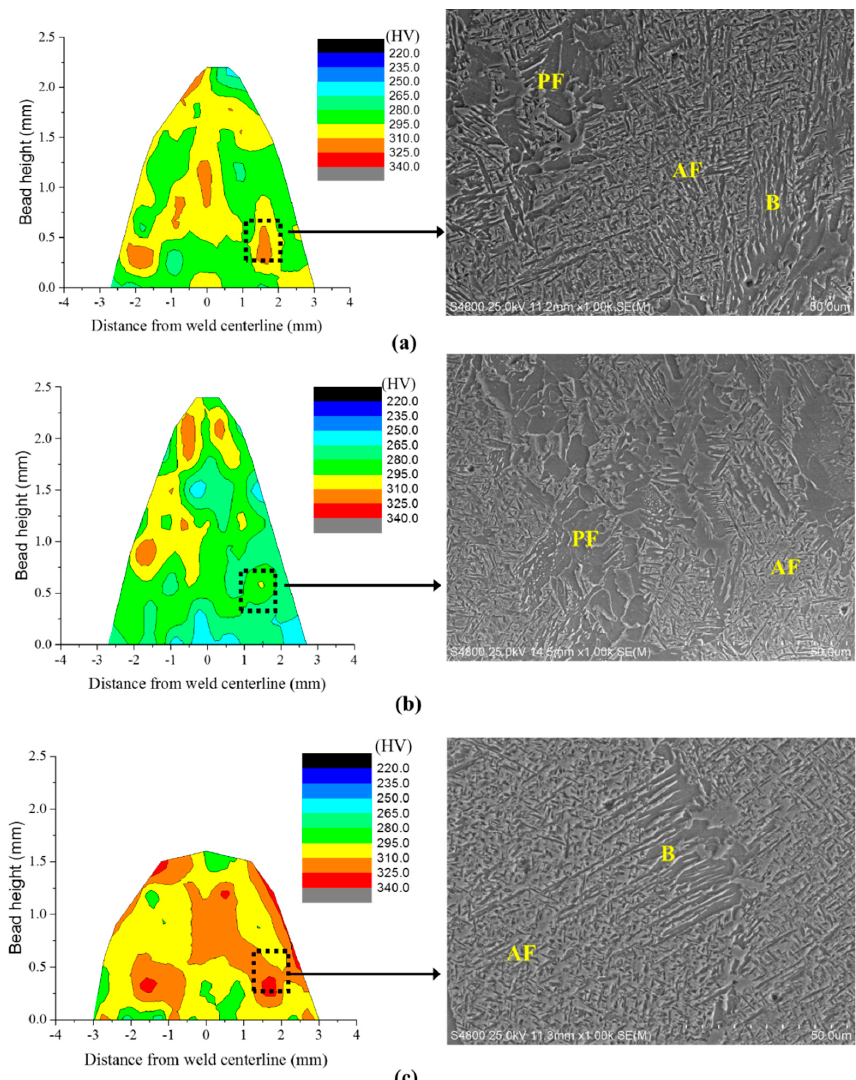
Figure 11. Hardness contour plots corresponding to microstructures in the weld metal: ( a ) flat position; ( b ) overhead position; ( c ) vertical down position.